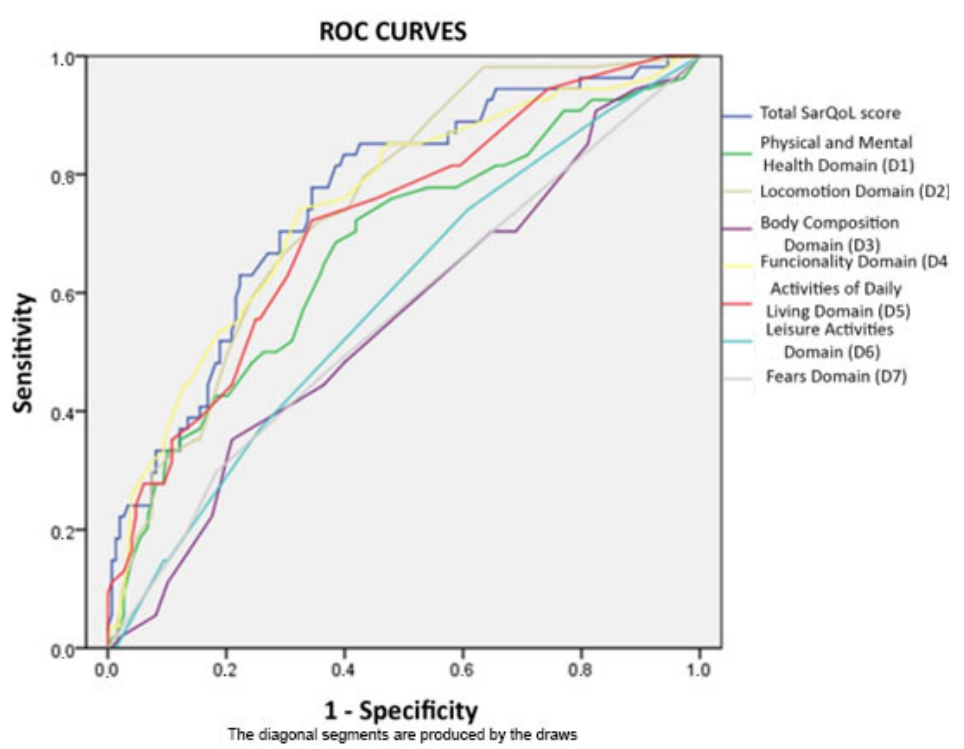
Figure 1. Multiple ROC curves developed for every SarQoL domain and total score. Table 4. ROC curves diagnostic performance values for each domain and total score of SarQoL questionnaire when it was used to discriminate sarcopenic pathology.